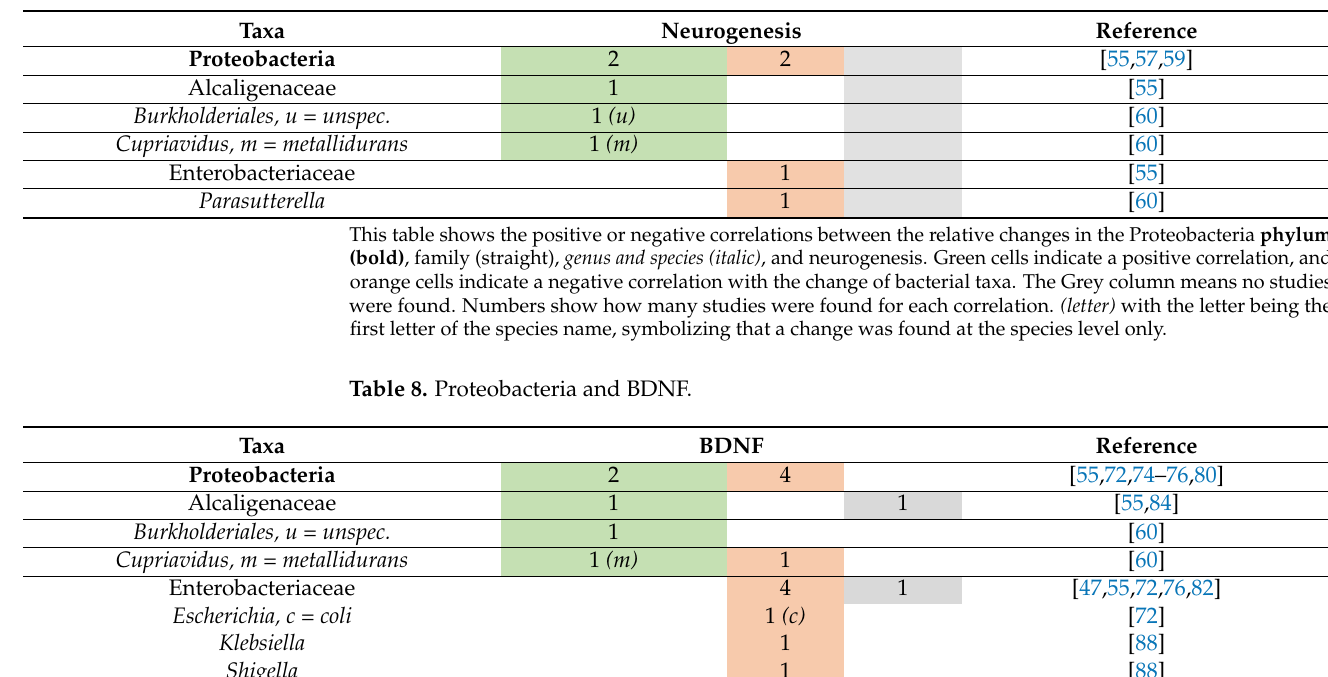
Table 7. Proteobacteria and neurogenesis.